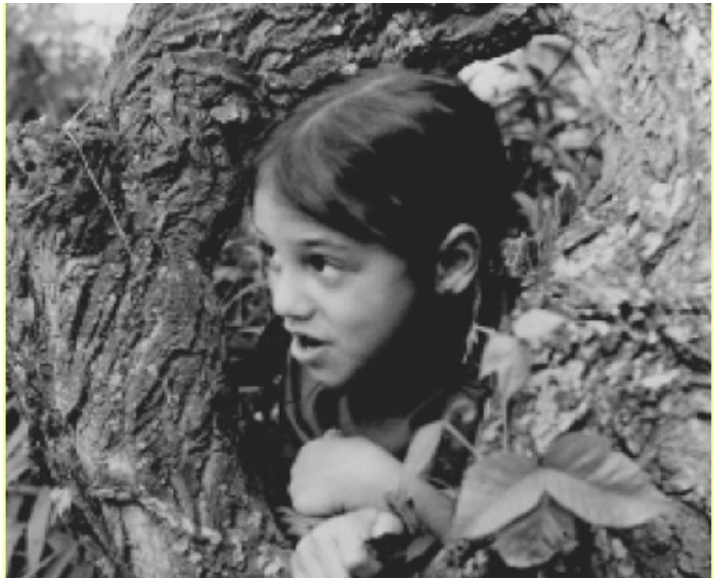
Figure 2. Nalini Nadkarni as a young child who loved to climb trees after school. Photo Credit: Moreshwar Nadkarni.